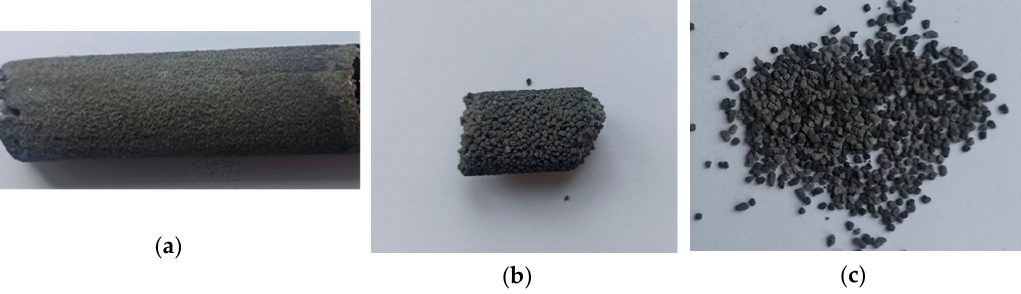
Figure 7. Photographs of synthesized Cr 2 N samples. ( a ) obtained by the combustion of chromium powder; ( b , c ) obtained by the combustion of granules of chromium.